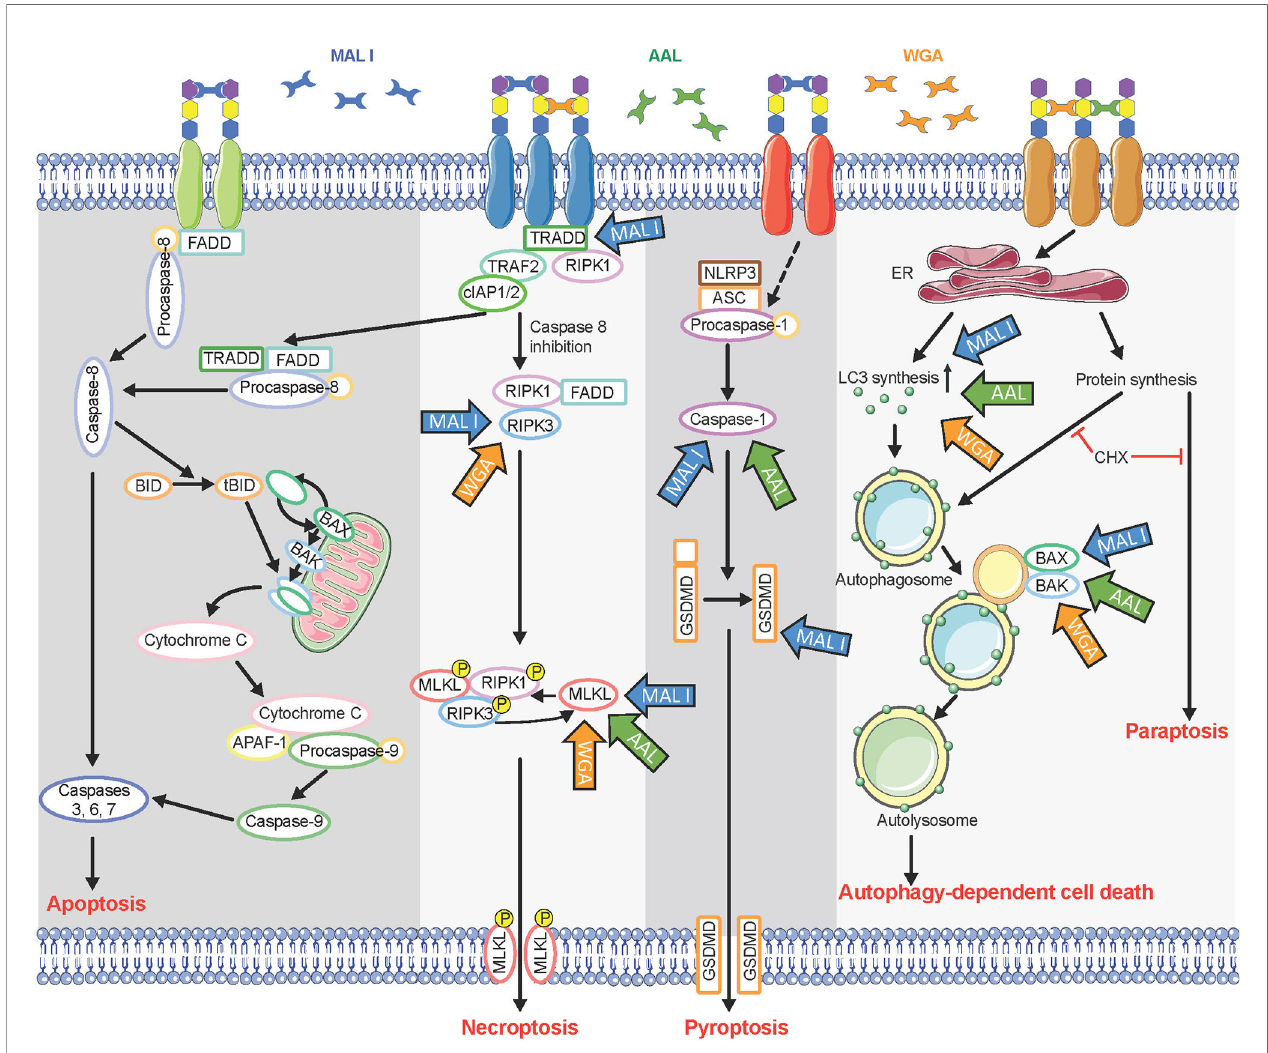
FIGURE 8 | Multiple cell death signaling pathways activated in response to lectin treatment. Glycan chains on surface glycoproteins are represented by colored hexagons. Blue, green, and orange arrows indicate components of cell death signaling pathways involved in the cytotoxic effects of MAL I, AAL, and WGA, respectively. CHX,